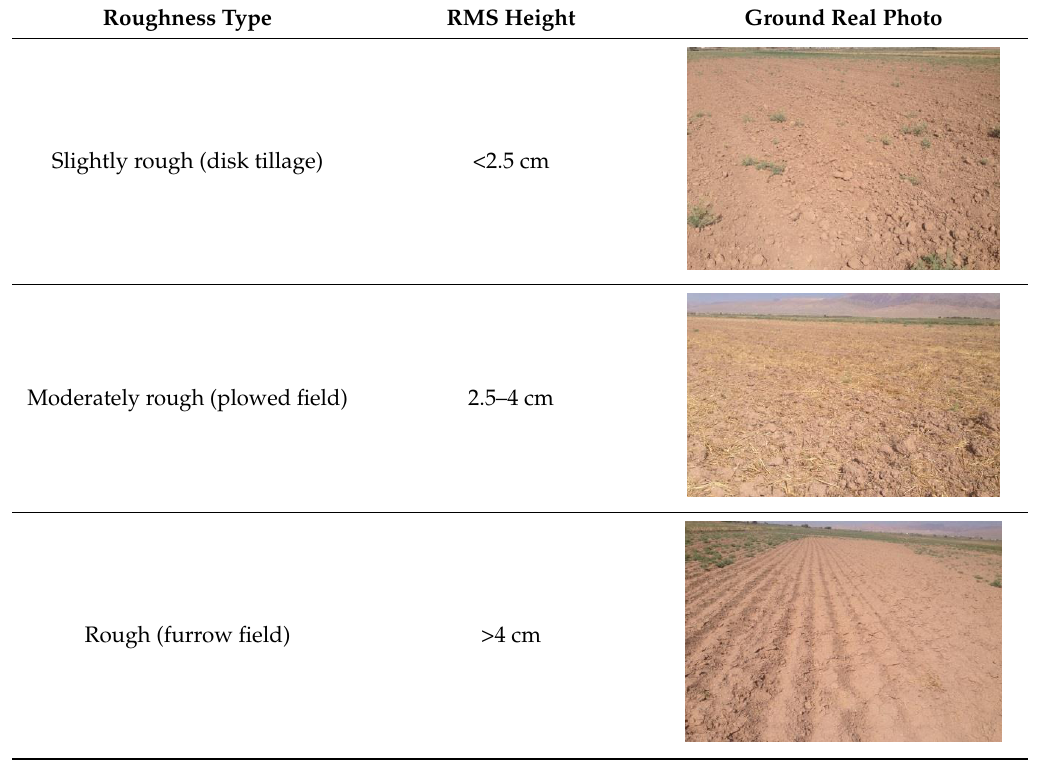
Table 4. The classification of the roughness types in the test site with real ground photos.